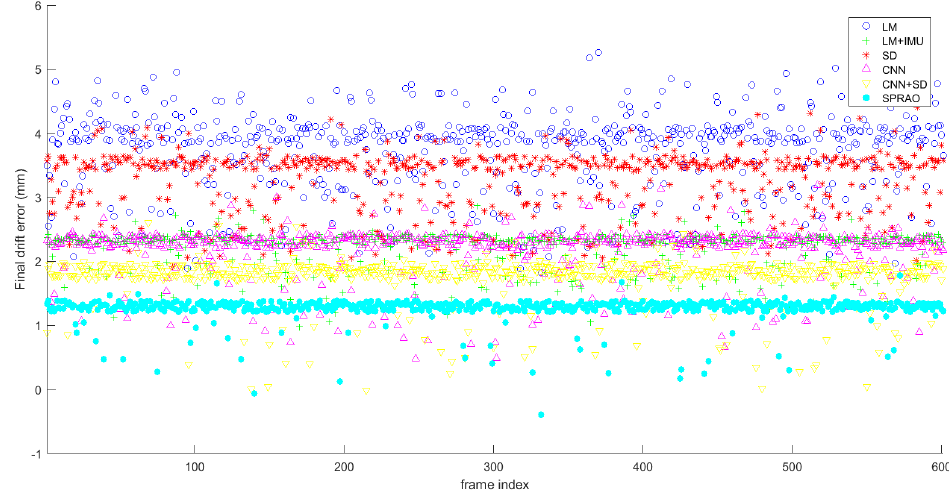
Figure 25. Reconstruction results of dataset DB3.